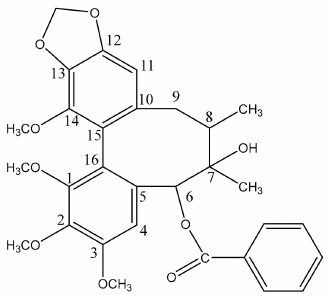
Figure 1. Chemical structure of Schisantherin A.